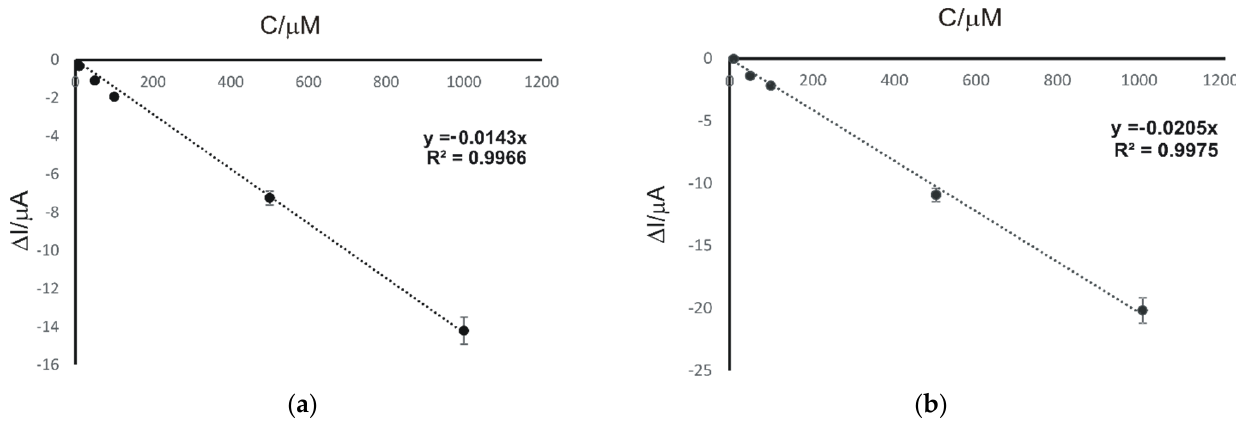
Figure 7. Linear dependence between Δ I and concentration of FA ( a ) and CA ( b ) based on voltam- metric measurements with CNF/SPE (concentration range is 10–1000 μ M). Table 2. Limit of detection (LOD) and limit of quantification (LOQ) values, line equation and R 2 of the CNF/SPE sensor for simultaneous detection of CA and